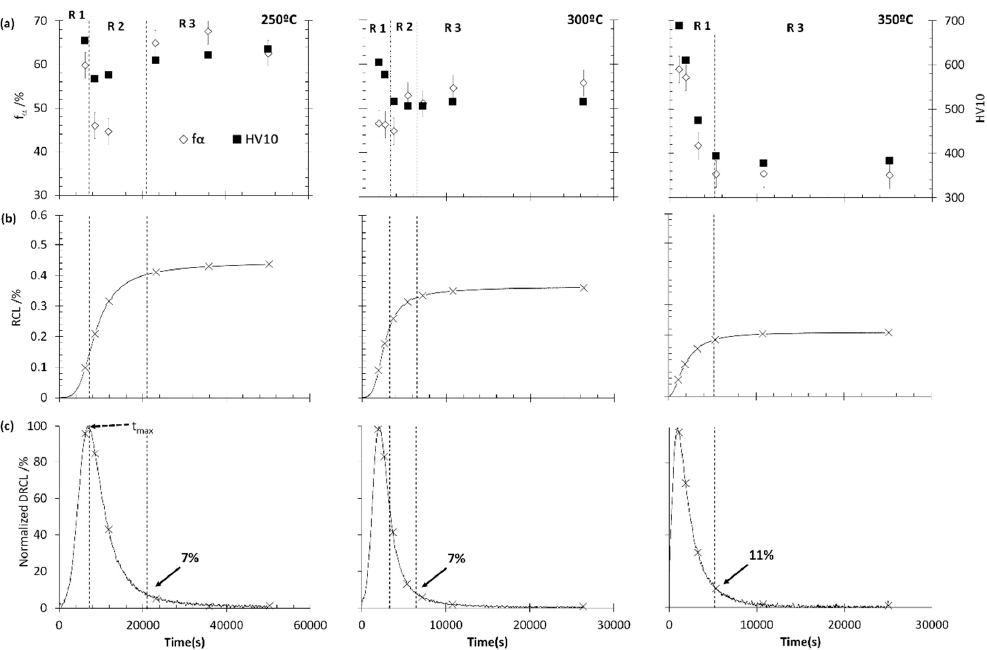
Figure 3. For Steel 2 treated at di ff erent isothermal temperatures and times, ( a ) experimental fraction of ferrite (f α ) and HV as a function of time, ( b ) the relative change in length (RCL) from the dilatometry test, and ( c ) normalized derivative of the relative change in length (DRCL). The x symbols in (b,c) indicate the position of the interrupted tests whose f α and HV are also indicated in (a). Vertical dotted lines denote the limits of di ff erent regions (R1, R2 and R3) as described in the main body of the text and schematically shown in Figure 1. Note that region R2 is not detectable in all cases.